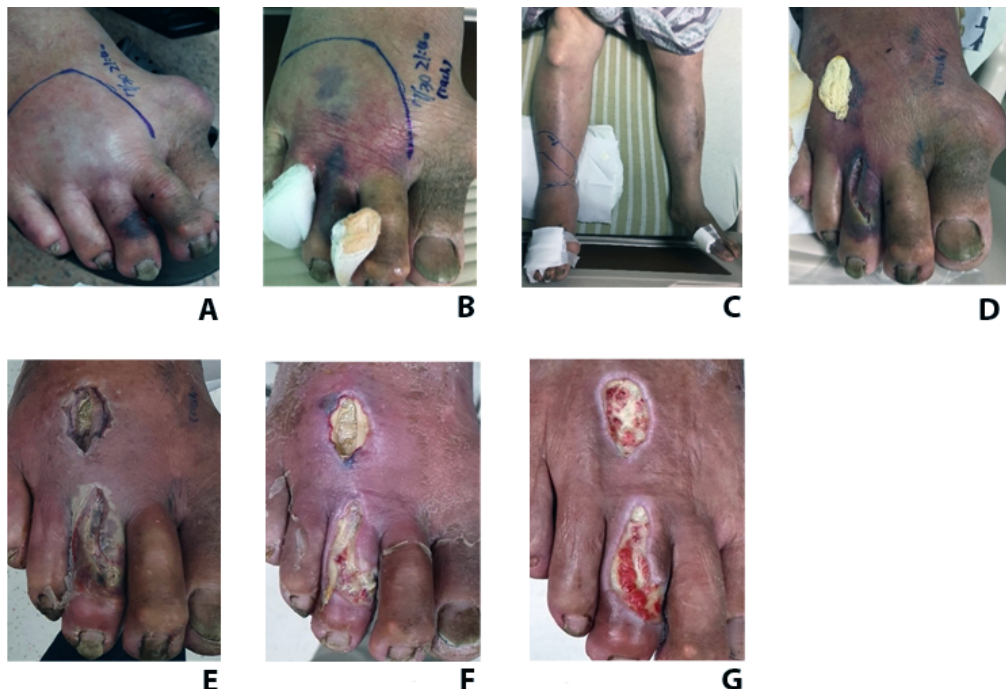
Figure 2. The evolution of wounds in a late debridement case. (A) A 66-year-old man was bitten by a cobra on the right 2 nd and 3 rd toes with necrotic signs within one hour of snakebite. (B) The necrotic lesion was observed on the right foot 17 hours later. (C) Limb swelling reached the right leg three days later. (D) Wound incision and minimal debridement. (E, F) Wound condition in one week, one month and two